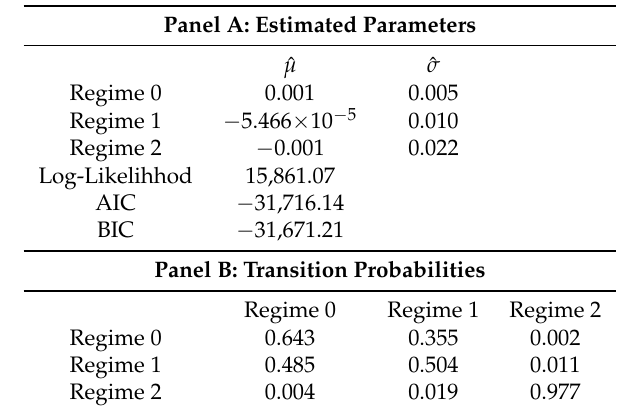
Table 5. 3-Regime Markov-switching models: estimated parameters for the Dow Jones Industrial Average index returns (2001–2020). AIC and BIC are the Akaike and Bayesian Information Criterion,